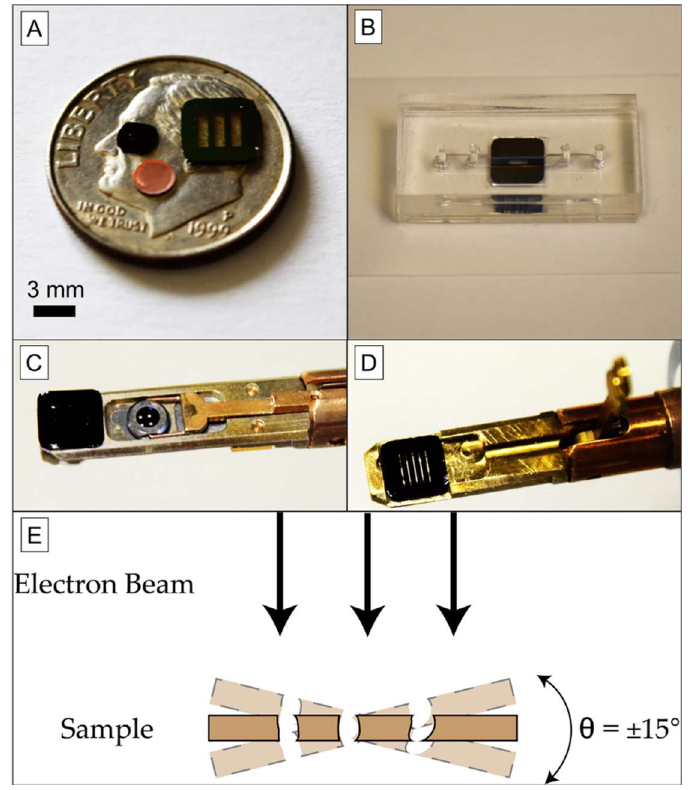
Figure 1. Experimental Setup. ( A ) Common TEM substrates are 3 mm circular copper grids or 3 mm silicon chips. Larger substrate formats are not commonly accepted by commercial TEM holders, since most are designed for 3 mm diameters. ( B ) A 5.4 mm square chip allows for more robust use in microfluidic devices compared to a smaller 3 mm chip or grid, which is more difficult to handle. ( C ) Image of an unmodified FEI TECNAI G20 TEM holder containing a 3-mm silicon chip, held in place by a cantilever with circular aperture (sample affixation clip), with a 5.4 × 5.4-mm 2 NPN chip on the end for scale. ( D ) Image of a modified FEI TECNAI G20 TEM holder containing 5.4 × 5.4 mm 2 NPN chip, with the affixation clip raised. The viewing area remains limited to the 2.8 mm circular aperture of the clip. ( E ) Tilted views of the sample are available using this modified holder, which are necessary for electron tomography.